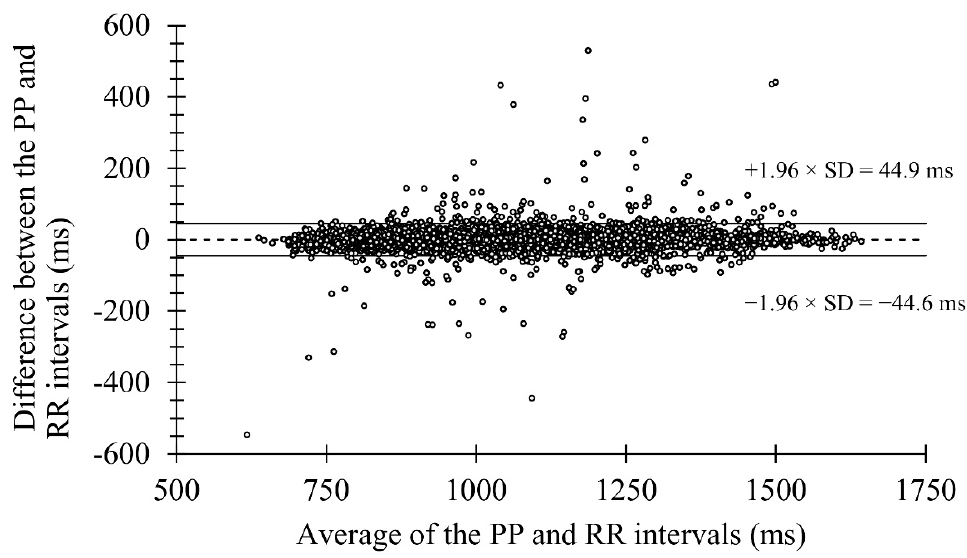
Figure 3. Bland-Altman plot presenting the mean bias and limits of agreement in the laboratory recordings.